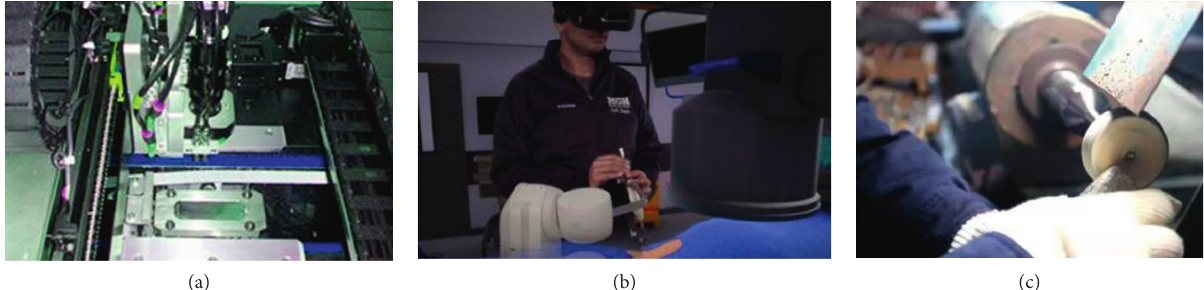
Figure 1: Constant working conditions. (a) High precision flexible assembly; (b) minimally invasive surgery; (c) complexity surface